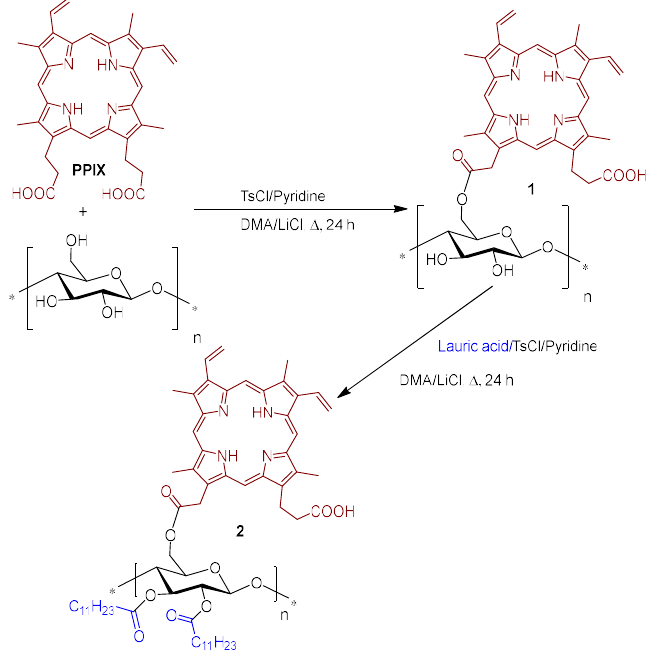
Figure 4. Synthetic approach for preparation of photobactericidal films 2 by “one-pot, two-step” esterification of cellulose with PPIX and lauric acid (adapted from Ref. [137] ).